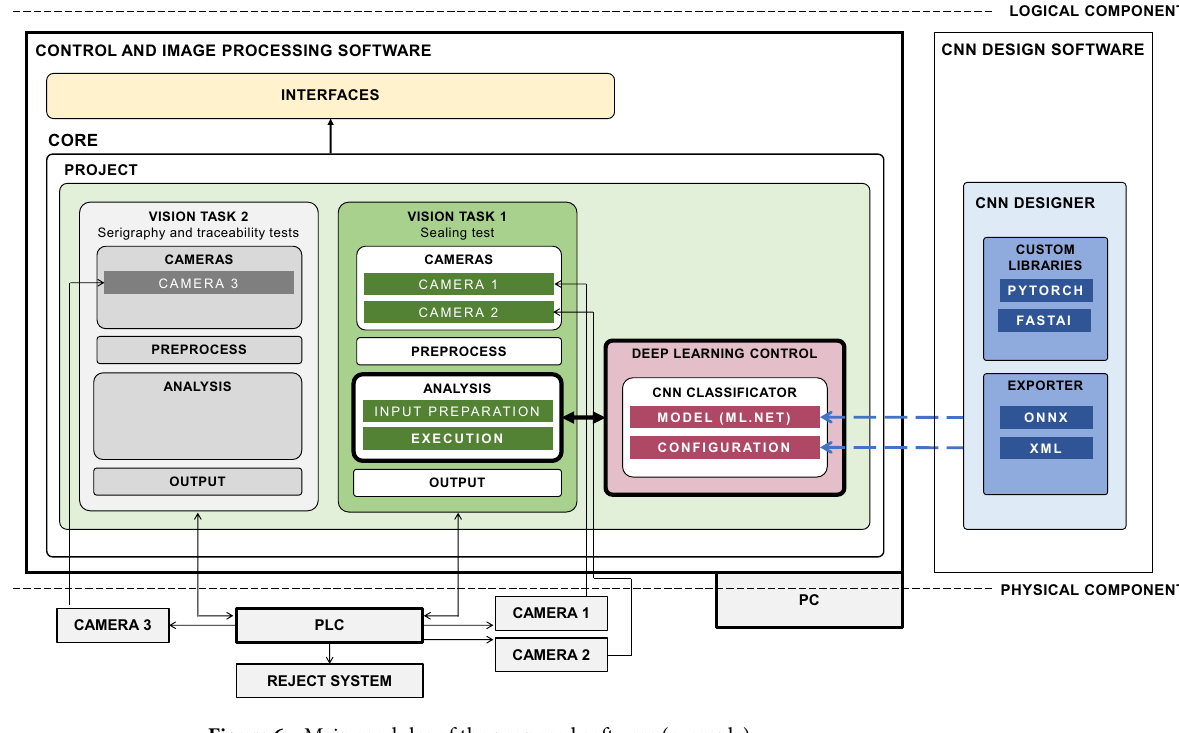
Figure 6. Main modules of the proposed software (example).